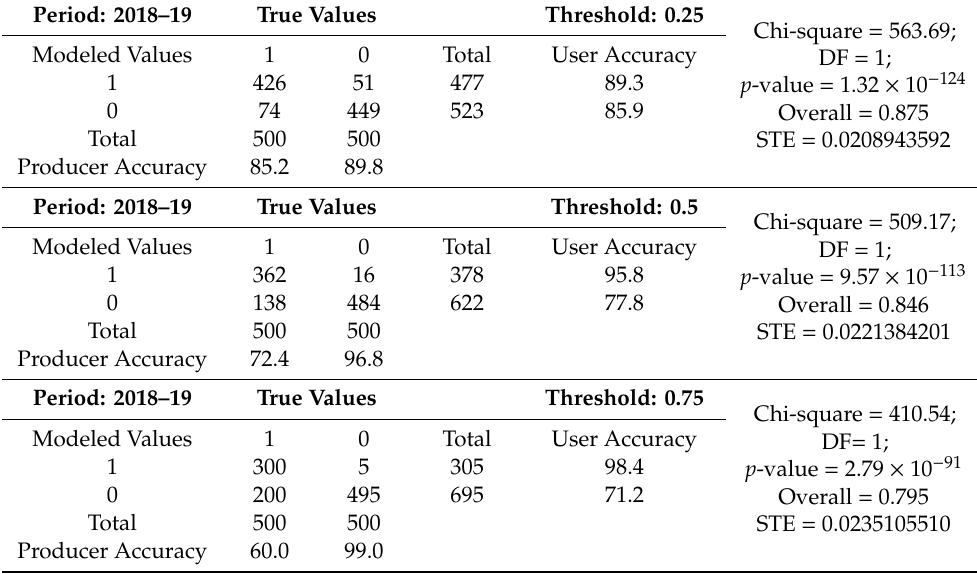
Table 6. Accuracy Assessment report for the period 2018–19, as estimated with the Raster Utility tools based on a validation dataset of 1000 random samples (50% in each class). Random Forests results were split into treatment and no treatment pixels based on three thresholds (0.25, 0.5 and